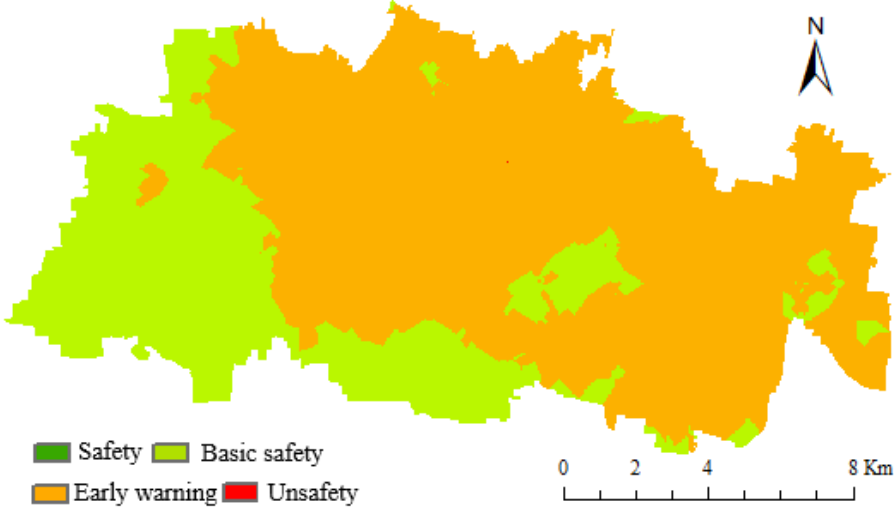
Figure 7. Predicted map of landscape ecological security in 2029.